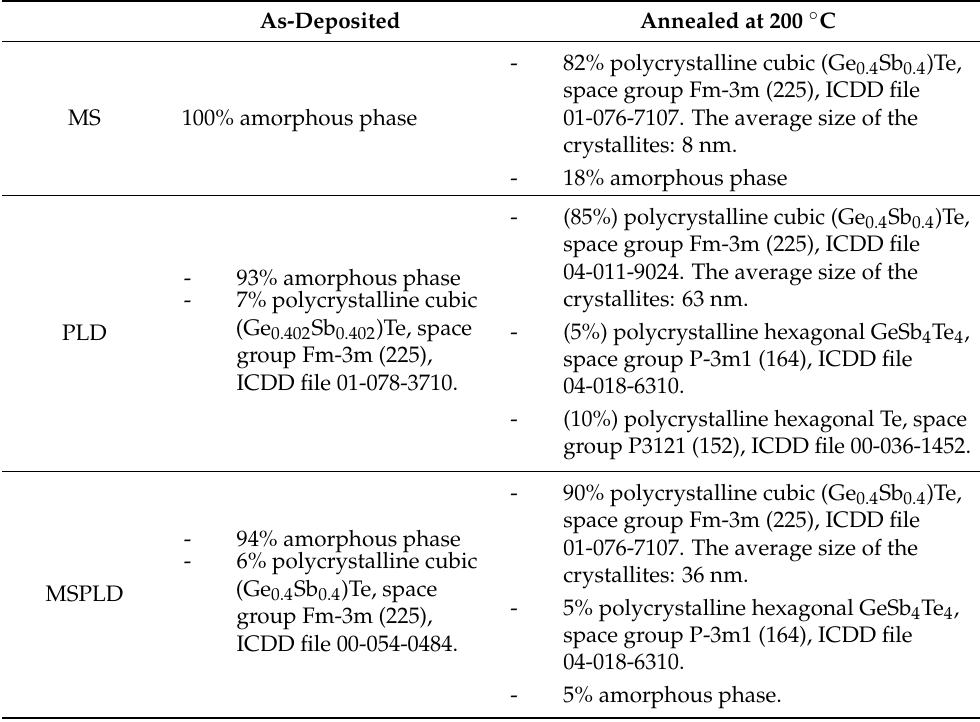
Table 3. Crystalline phases in GST-225 thin films. The average size of the crystallites was approxi- mated using Scherrer equation for (200) c-GST-225